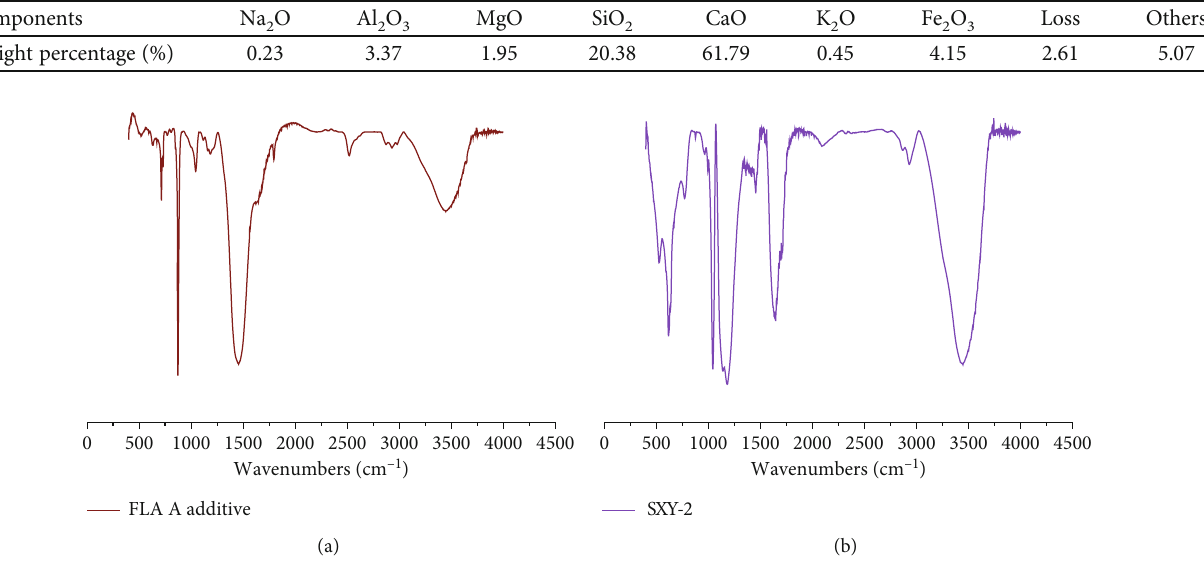
Figure 2: FTIR analysis of FLA A additive and SXY-2 dispersant. Table 2: Testing and characterization